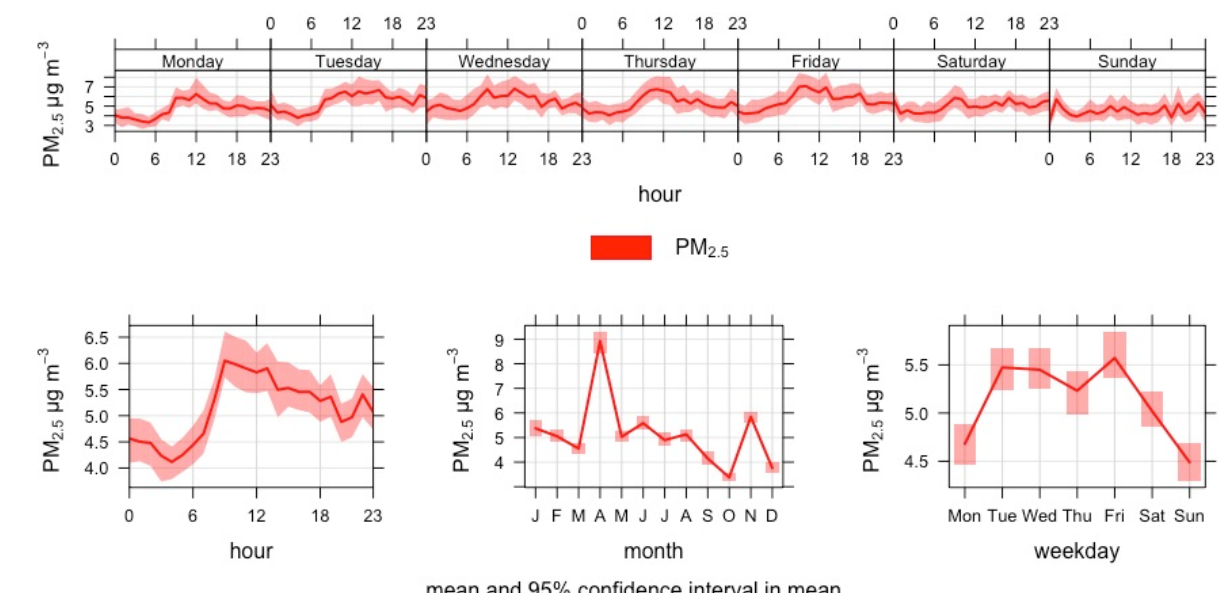
Figure 11. Time variation plot of PM 2 . 5 concentration at Helsinki West Harbour in 2019. The multivariable linear regression found a statistically significant association with arrivals, departures, movement and vessels at berth and the natural logarithm of hourly mean PM 2 . 5 concentrations when adjusted for wind direction, wind speed, relative hu- midity and time of day. However, none of the vessel movement parameters were statisti- cally signi fi cant when the analyses were run with the weekend-only data (Table 9). The models explain only 7–10% of the variation in the hourly mean PM 2 . 5 . Based on the anal- yses, the association between vessel movement and PM 2 . 5 concentration seems weak or non-existent. Table 9. Multivariable linear regression analysis results for vessel arrivals, departures, movement and laying alongside to the logarithm of PM 2 . 5 hourly mean concentrations controlled for wind di- rection, wind speed and time of day at the West Harbour in 2019. p -values less than 0.05 in bold. Coefficient adj. r 2 Linear regression models for the whole year, all vessels (8055 observations) Arrival 0.066 Linear regression models for weekends, all vessels (2294 observations) Arrival